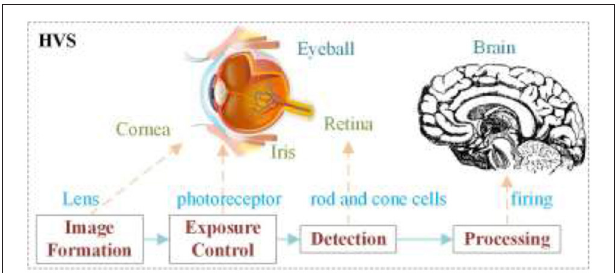
FIGURE 6 | Illustration of a simplified